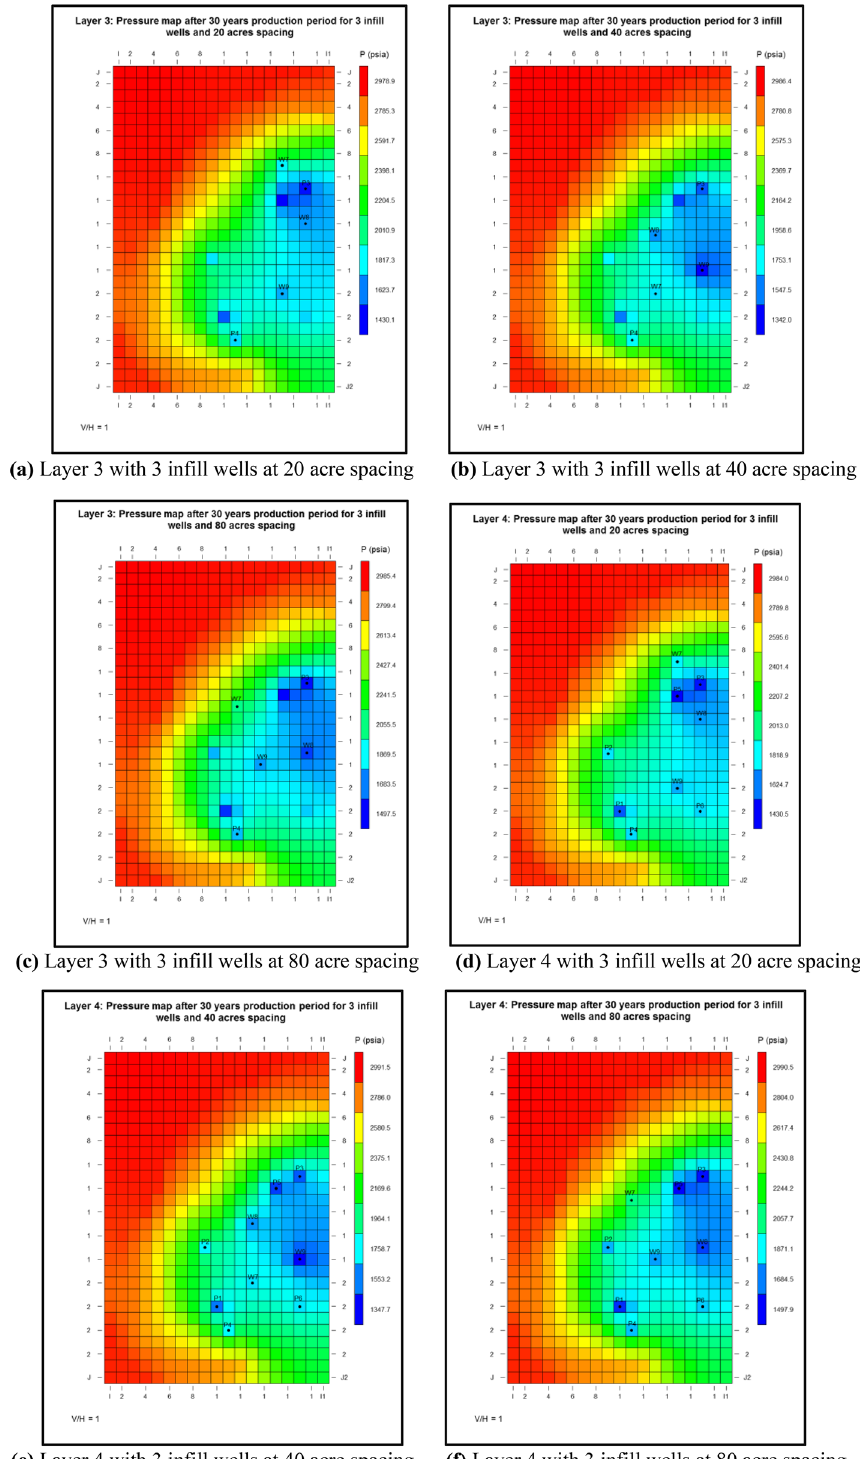
Fig. 9 Pressure distribution maps for layers of the reservoir with 3 infill wells located at dif- ferent well spacings (additional 15 years simulated production